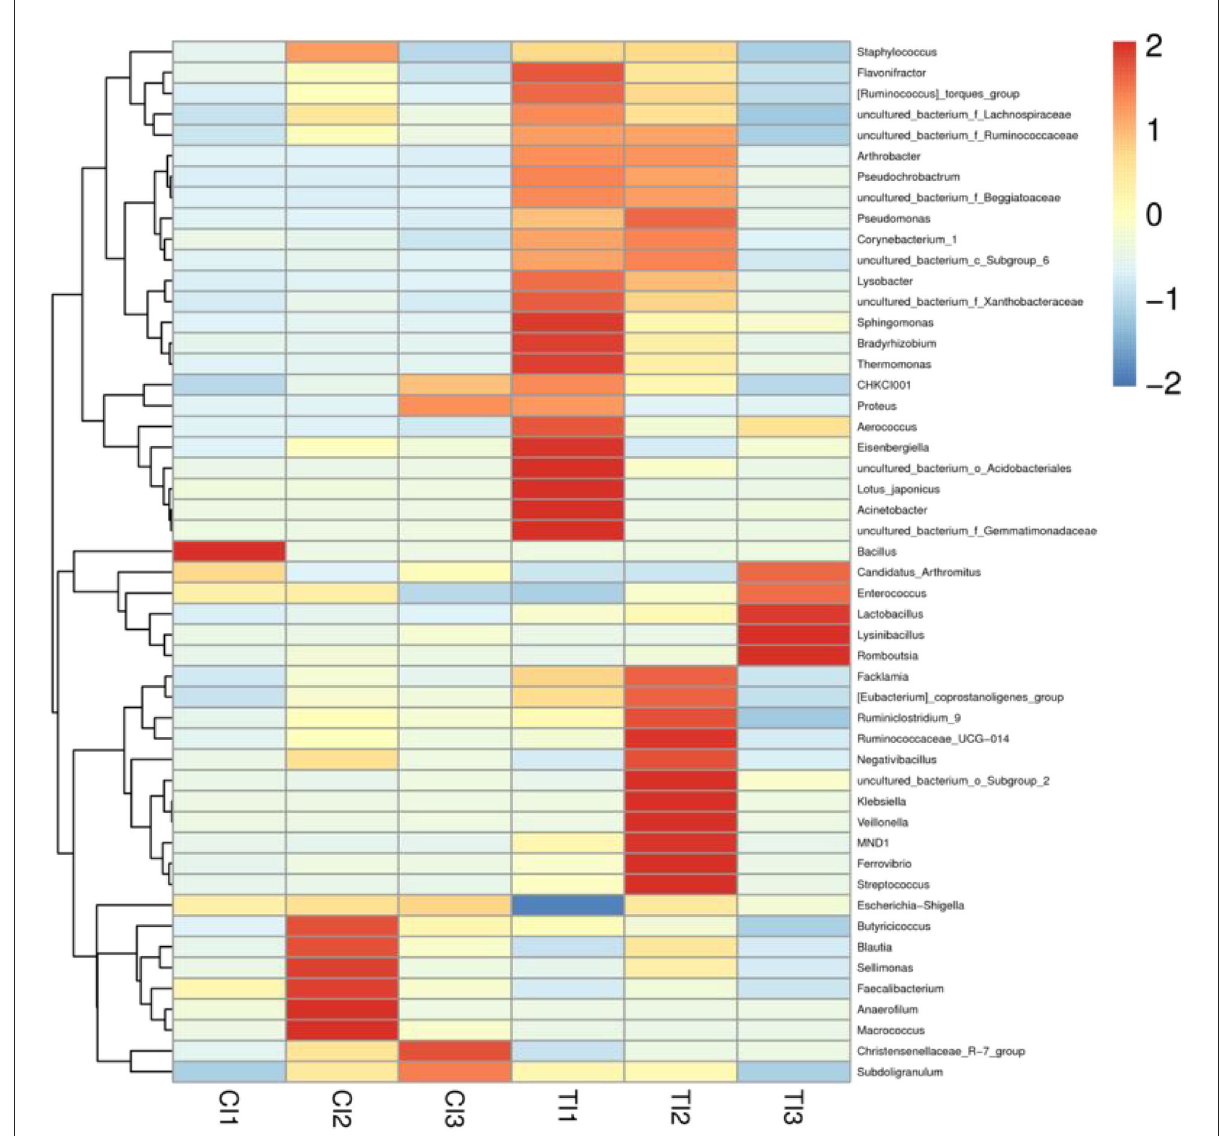
FIGURE3 Heatmap revealing the relative abundances and distribution of the 50 most preponderant bacterial genera in both groups. The changes in blue to red of the color-block indicate the relative abundance from low to